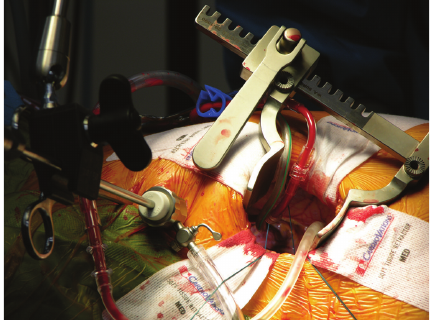
Figure 3: Direct transthoracic aortic